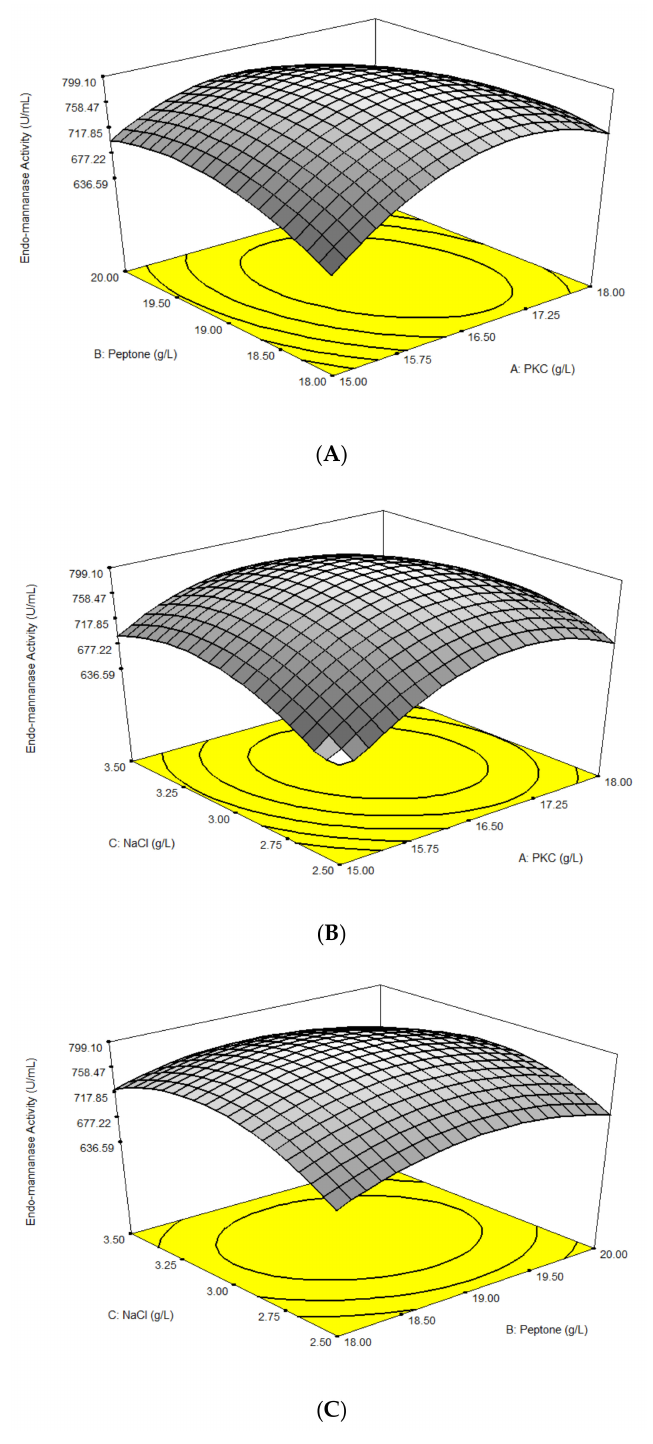
Figure 2. Surface plot obtained from optimization using RSM for the combination e ff ect of ( A ) PKC concentration and peptone concentration (by keeping NaCl concentration at center point), ( B ) PKC and NaCl concentration (by keeping peptone concentration at center point) and ( C ) NaCl and peptone concentration (by keeping PKC concentration at center point) on β -mannanase